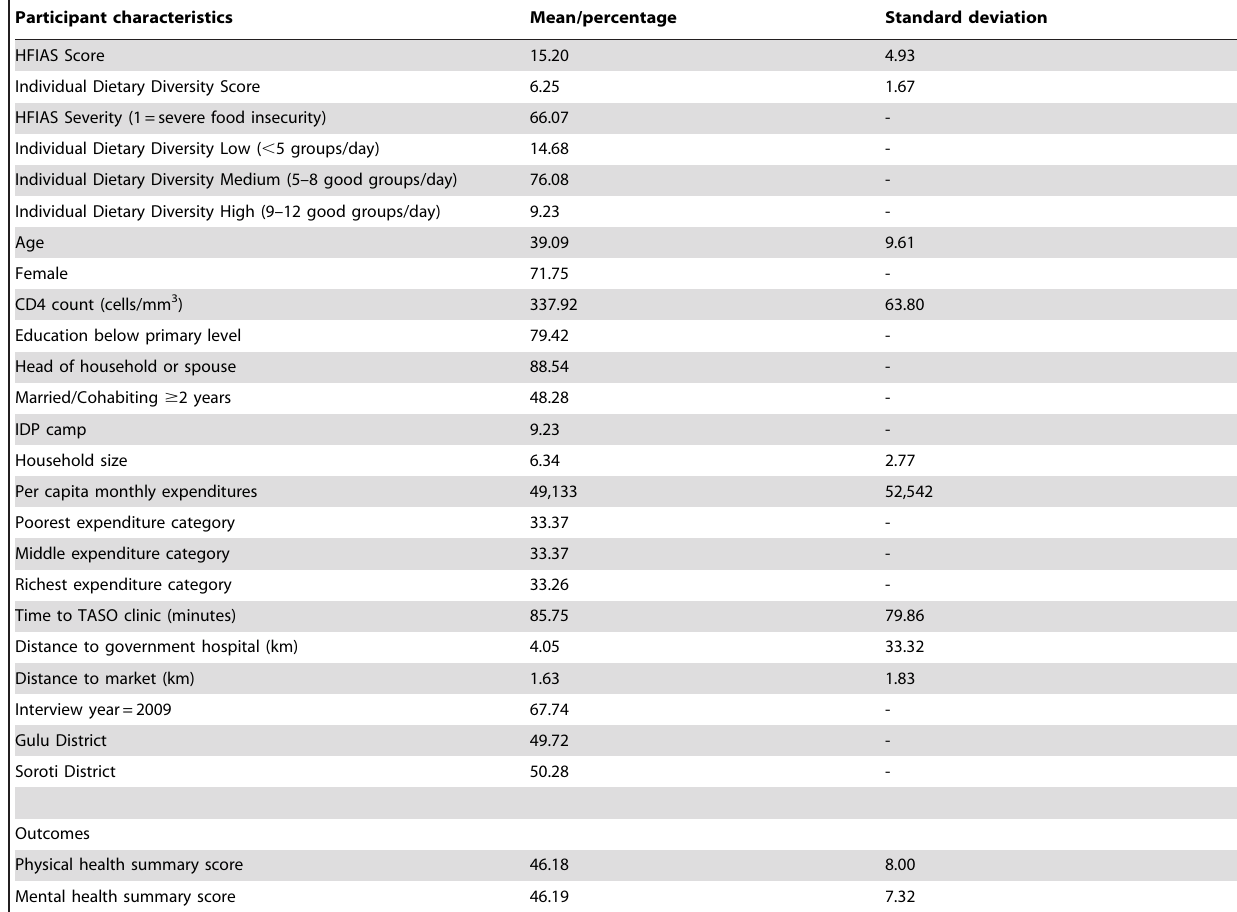
Table 2. Summary Statistics